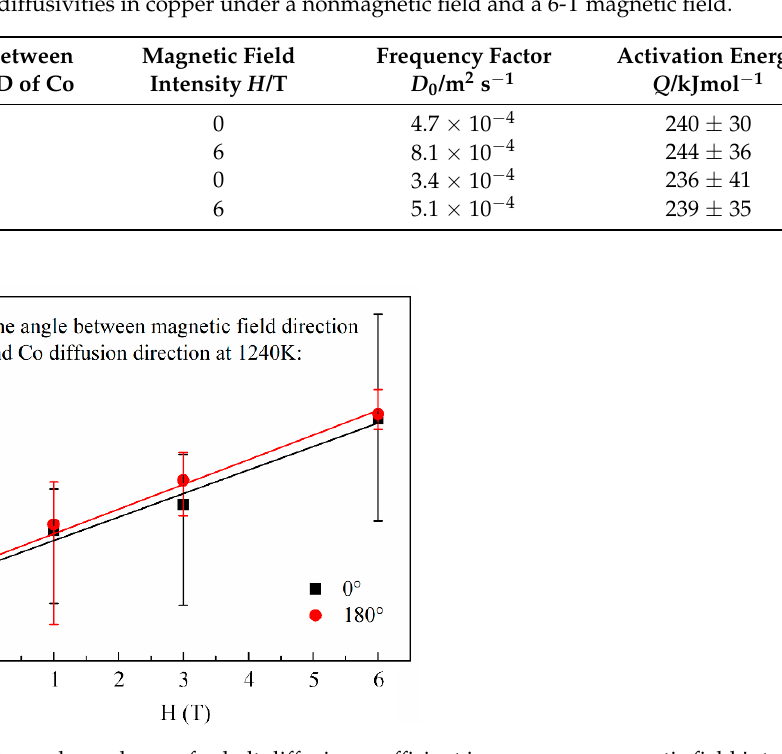
Figure 4. Arrhenius plots for cobalt diffusivity in copper with and without a high magnetic field. The angle between the magnetic field direction and the cobalt diffusion direction: ( a ) 0° and ( b ) 180°. For comparison, the previous data of Bruni, F. J. [20] and Döhl, R. [21], which were measured under the nonmagnetic field, are presented by the dash and dash-dot lines, respectively. Table 2. Frequency factor D 0 and activation energy Q (standard deviation for 95% confidence) for